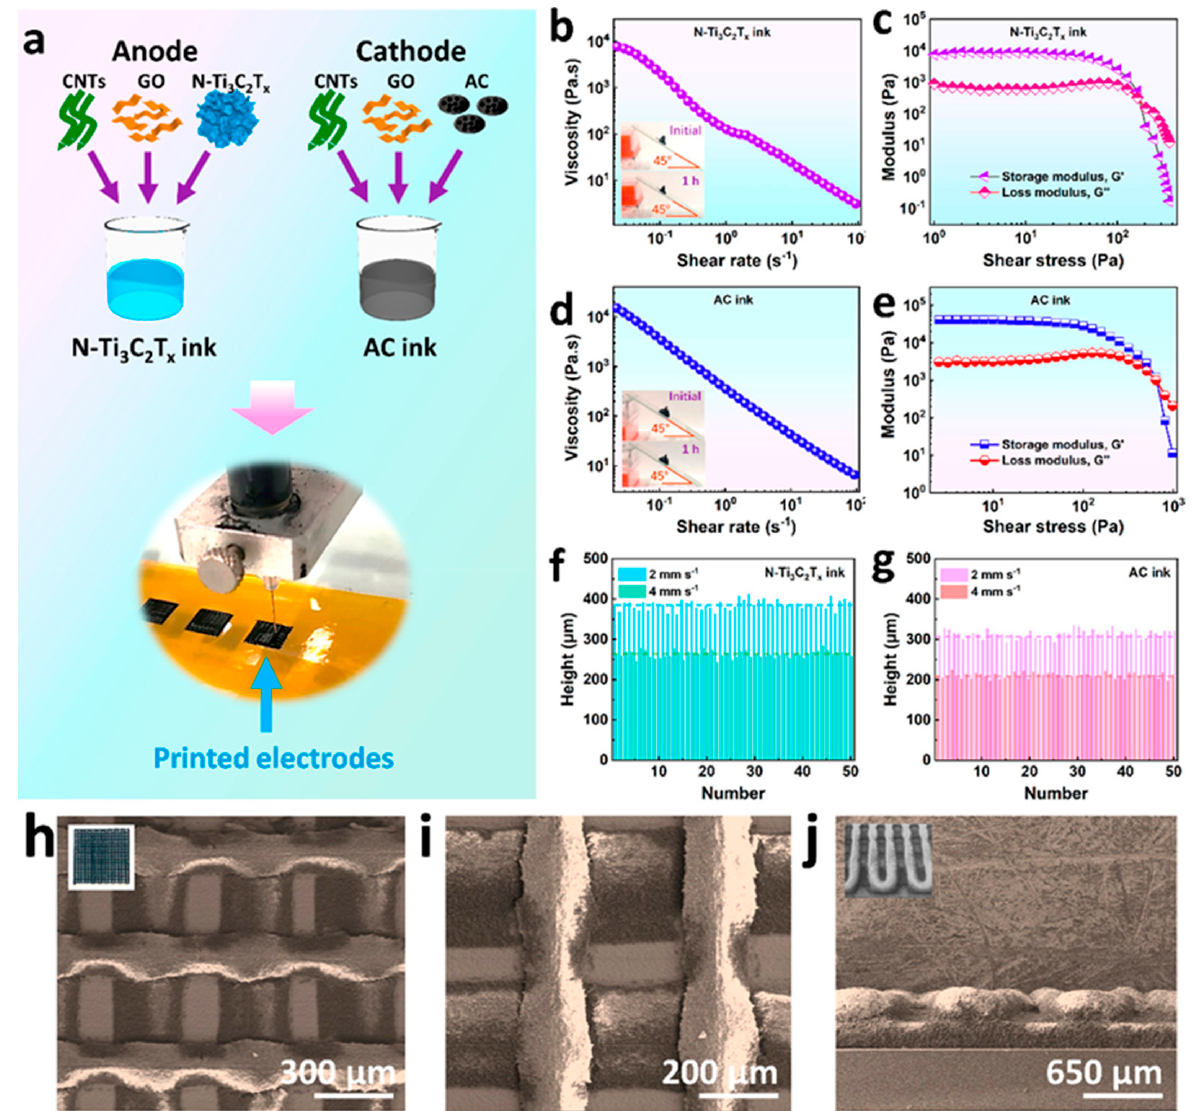
Figure 10. Description of a 3D printing method, rheological properties of inks, and microstructure of the woodpile-shaped electrodes. ( a ) Illustration of the printing process of the 3D-printed cathode and anode. ( b ) Apparent viscosity as a function of shear rate for the N-Ti3C2Tx ink. ( c ) Storage modulus (G ′ ) and loss modulus (G ′′ ) as a function of the shear stress for the N-Ti3C2Tx ink. ( d ) Apparent viscosity as a function of shear rate for the AC ink. ( e ) Storage modulus (G ′ ) and loss modulus (G ′′ ) as a function of the shear stress for the AC ink. ( f , g ) Height distribution of the 3D-printed ( f ) N-Ti3C2Tx (M8T1) and ( g ) AC lines with changed speeds. ( h – j ) SEM micrographs of the ( h , i ) top analysis and ( j ) side analysis of the 3D-printed N-Ti3C2Tx electrode. The inset in ( h ) displays a real photograph of the woodpile electrode. The inset in ( j ) shows a low-magnification SEM image of the woodpile electrode. Reprinted with permission from Ref. [94], Copyright 2020 by the American Chemical Society.